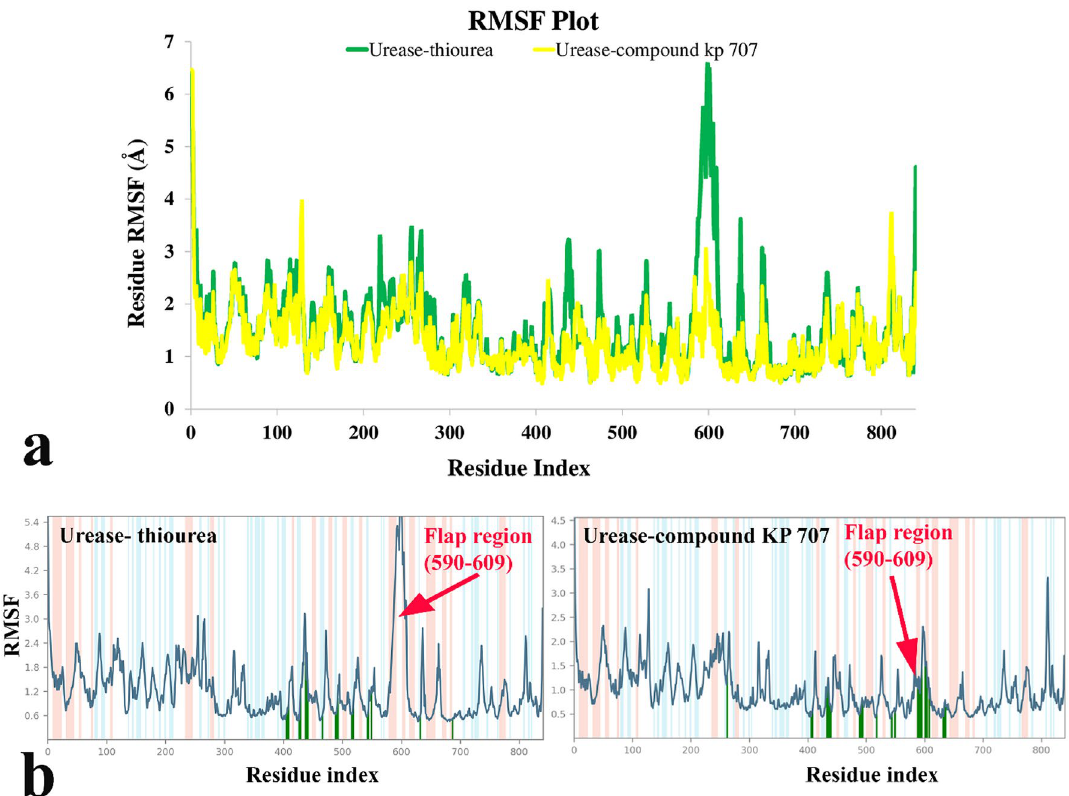
Figure 6. RMSF plot of the urease residue in complexed with thiourea (in green) and compound 3n (in yellow) ( a ), individual RMSF plot regards to ligand binding location over 30 ns MD simulation time ( b ). α-helical and ß-strand regions are highlighted in light pink and blue backgrounds, respectively.